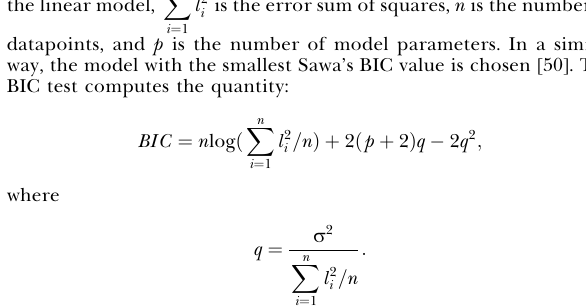
Table S1. Results of the Chemical Analysis of the Maize Residues before Addition to the Microcosm (Percent of Dry Weight) The isolines of the transgenic cultivars Novelis (Event MON810) and Valmont (Event 176) and conventional cultivars Nobilis and Prelude are in roman numbers on the upper row. Valmont showed the highest contents of proteins, fats, and sugars. Using the control as appropriate nesting specification to fit the data on soil respiration to a multilevel generalized linear model (untreated or treated soils; if treated: conventional or transgenic straw; if transgenic: straw with either a low or a high Cry1Ab content), sugars became the most significant predictor for the rate of CO 2 production ( p ¼ 0.0015), followed by the Cry1Ab protein ( p ¼ 0.0037), other proteins ( p ¼ 0.0134), and fats ( p ¼ 0.0144). Table S2. List of the BIOLOG EcoPlate Carbon Sources with the Pearson Product-Moment Correlation Coefficient, r, between the Specific Sources and the Concentration of the Cry1Ab Protein as Measured at the Beginning of the Experiment (Table S1). Found at DOI: 10.1371/journal.pcbi.0020128.st002 (41 KB